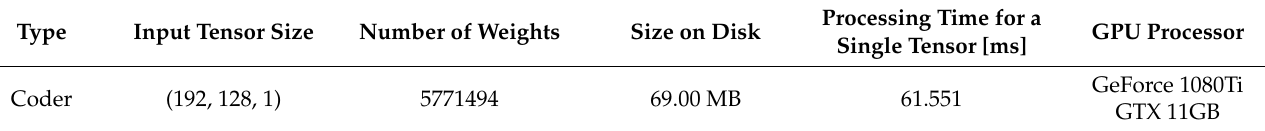
Table 5. Parameters of the